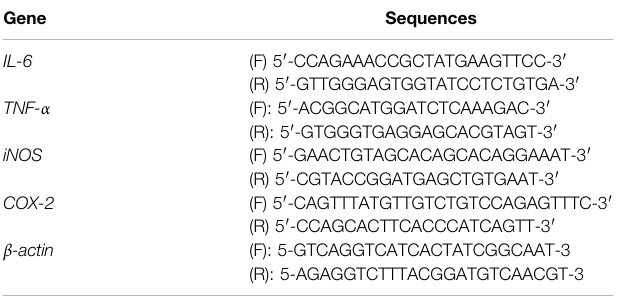
TABLE 1 | Primer sequences for quantitative PCR.